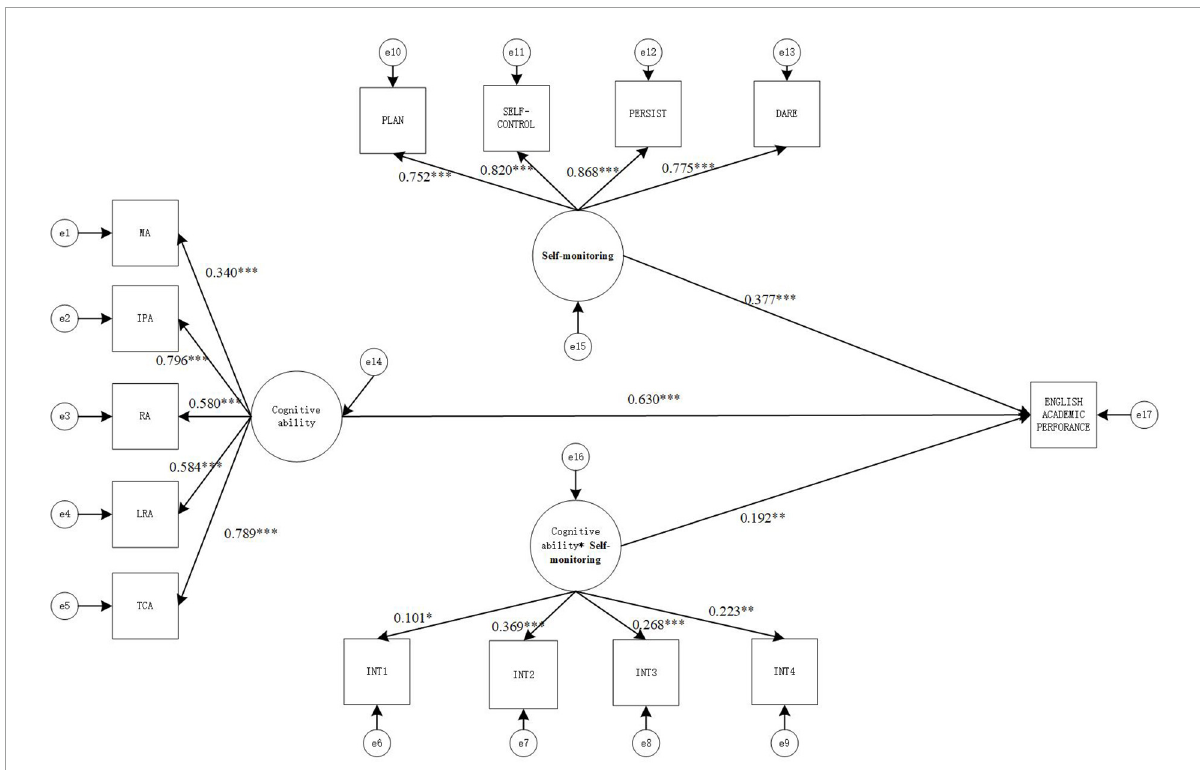
FIGURE6 Structural equation moderating effect relationship model diagram (model 4). MA, memory ability; IPA, information processing ability; RA, representation ability; LRA, logical reasoning ability; TCA, thinking conversion ability. * p < 0.05, ** p < 0.01, and *** p < 0.001.